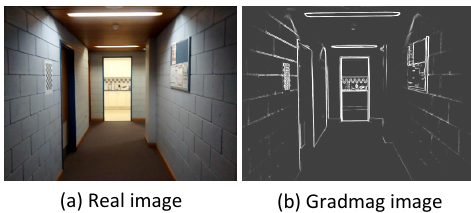
Figure 4. A real image and its gradient magnitude image.